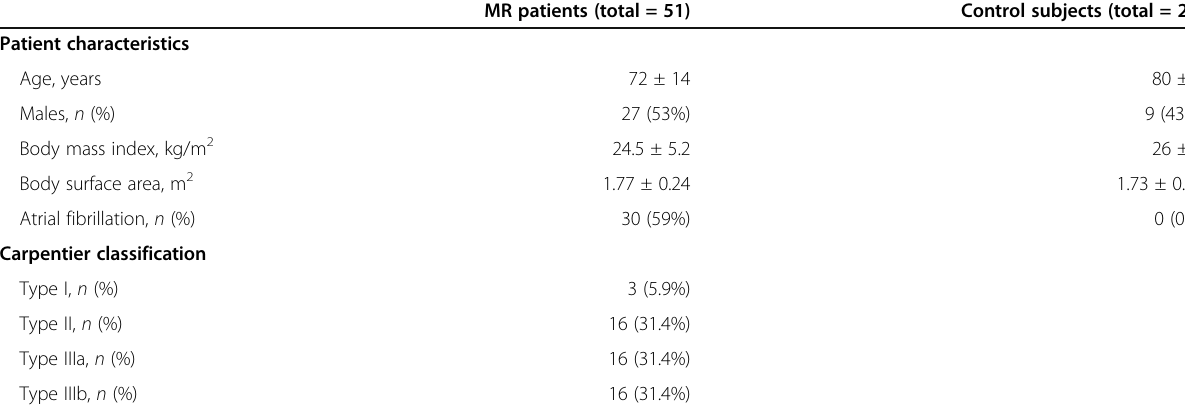
Table 1 Baseline patients ’ characteristics